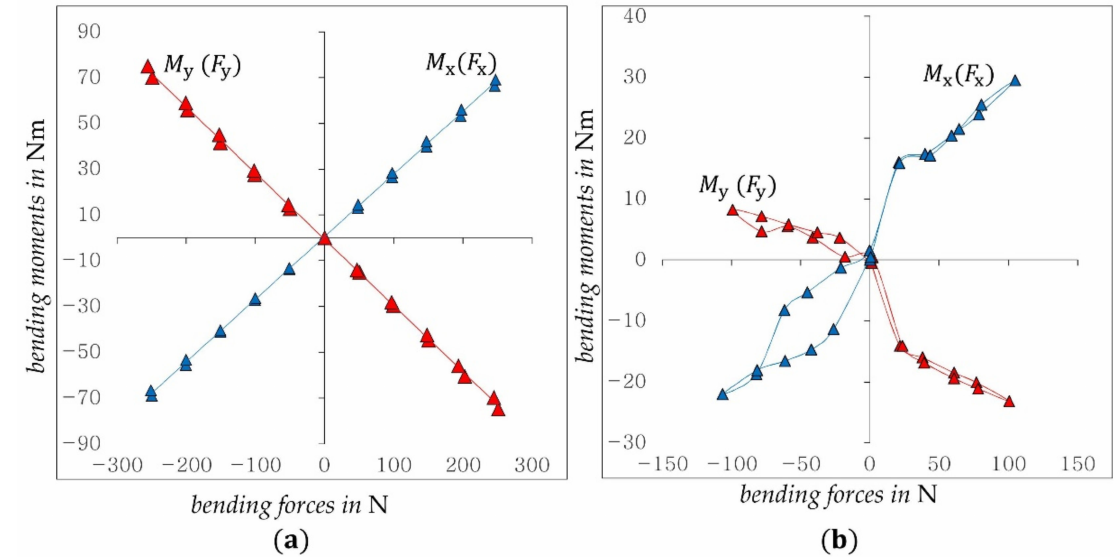
Figure 13. Correlation of bending moments to bending forces in both load cases ( a ) for F x + F y + M z and ( b ) for F x + F y + F z + M z